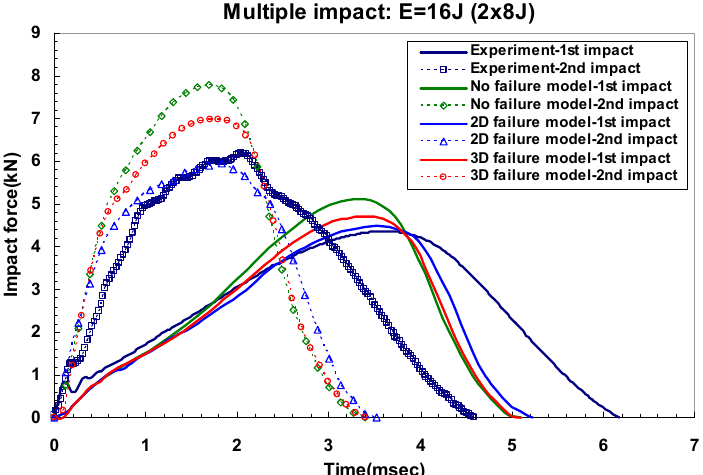
Figure 17. Multiple impact force-time curves. Comparison of experimental and simulation results for GLARE 5-2/1 under impact energy of 16 J. Table 7. Difference between predicted and measured peak impact force for GLARE 5-2/1